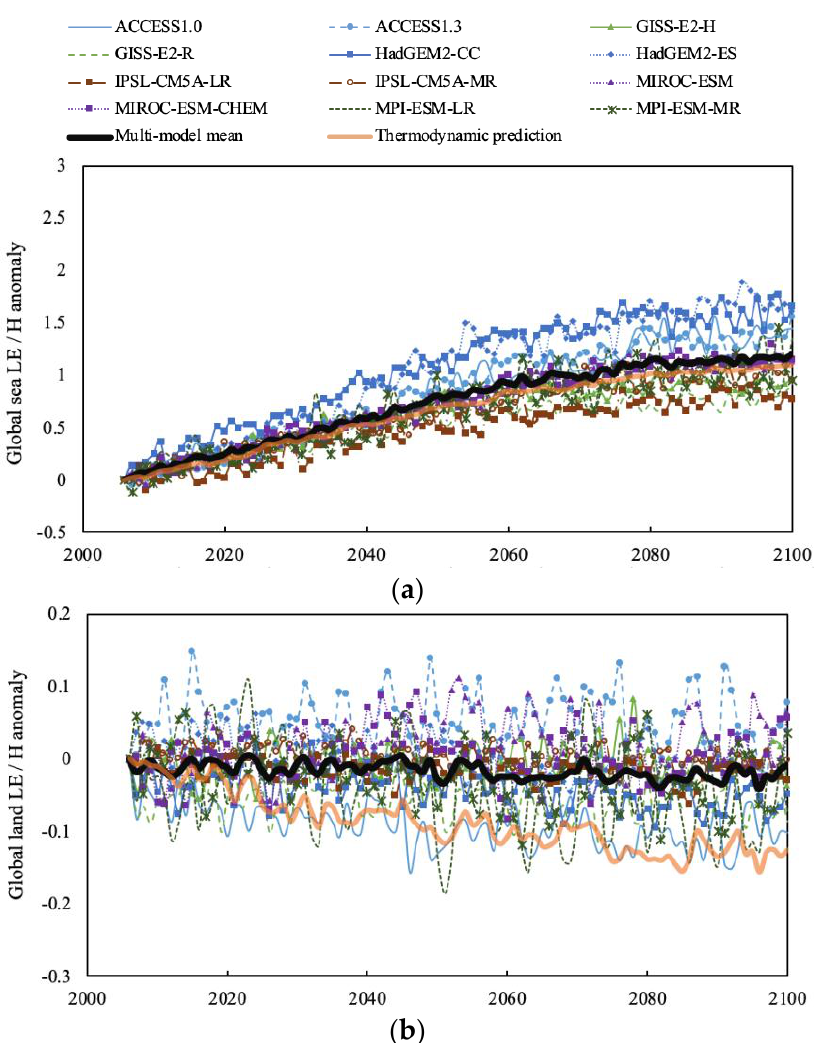
Figure 5. Anomaly of global relative efficiency in the RCP4.5 scenario of CMIP5 simulations over ( a ) sea and ( b ) land.